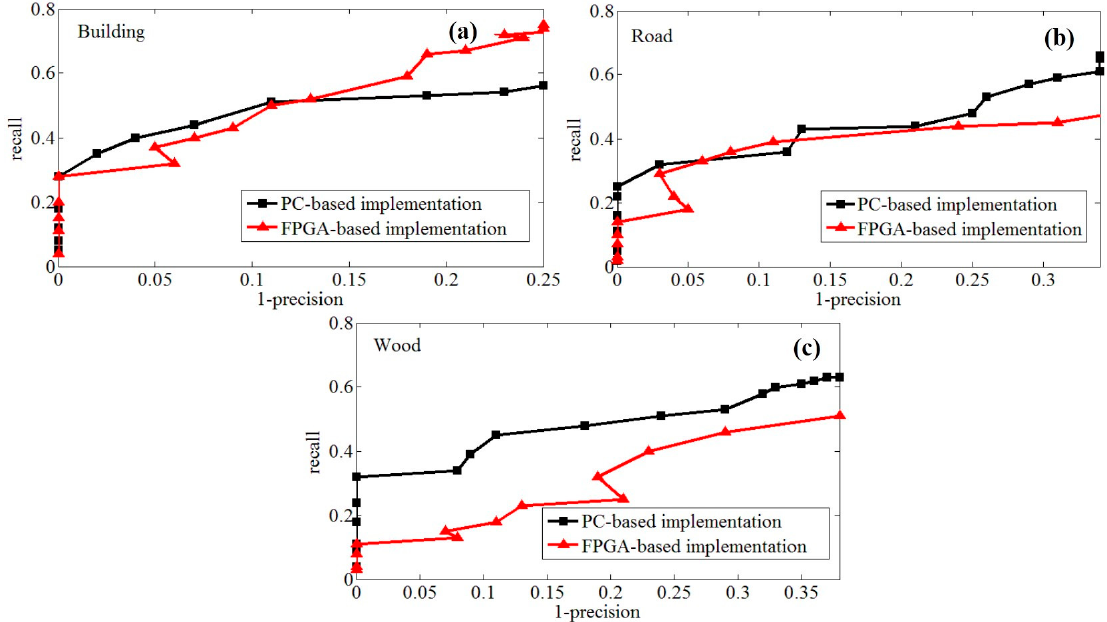
Figure 12. Comparison of FPGA-based and PC-based implementation of SURF + BRIEF algorithm in image pairs with building ( a ), road ( b ), and wood ( c ).